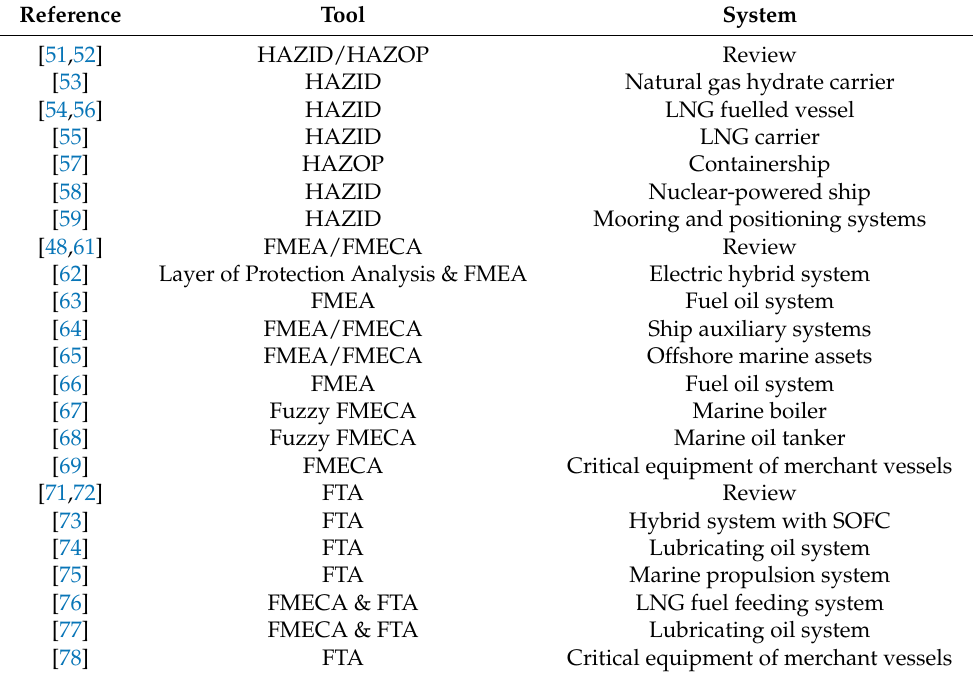
Table 1. Tools for safety and reliability assessment of marine